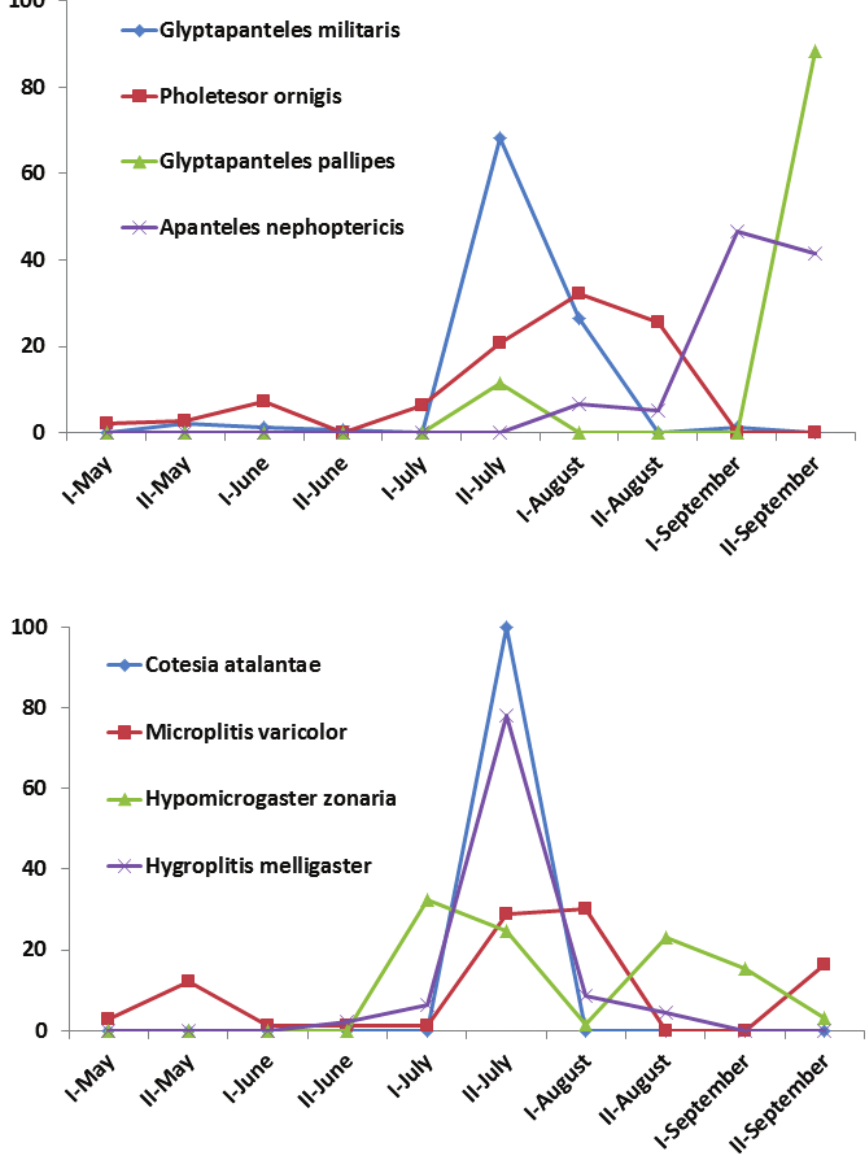
Figure 4. Bi-weekly (March-November) abundance of the eight most common species of Microgastrinae collected in Ottawa, based on CNC holdings only